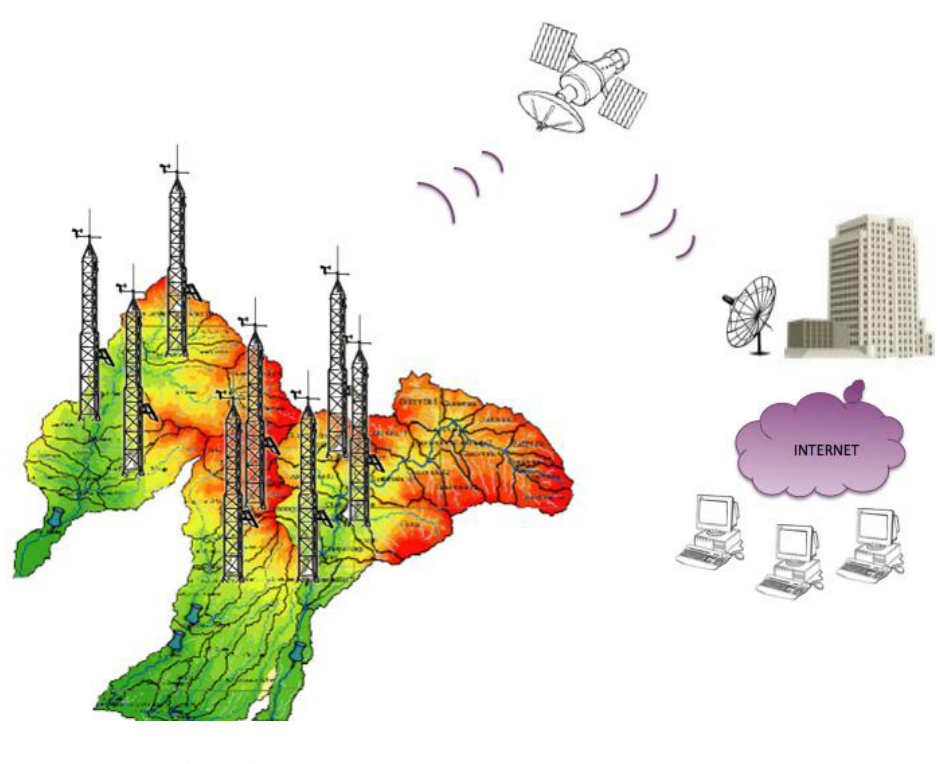
Figure 1. General overview of the proposed system, on the left side the ISM network, on the center and right side the KU Band Satellite link and on the right side the monitoring